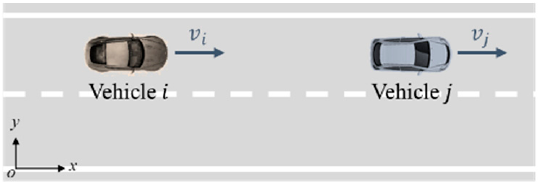
Figure 8. Car-following experimental scenario.